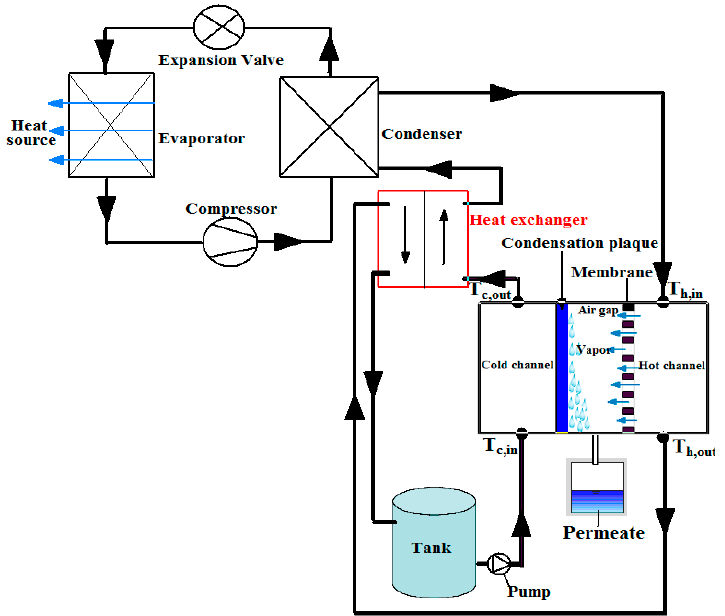
Figure 7. Scheme of the heat pump prototype coupled to the AGMD unit. Reprinted from [9] with permission from Elsevier.